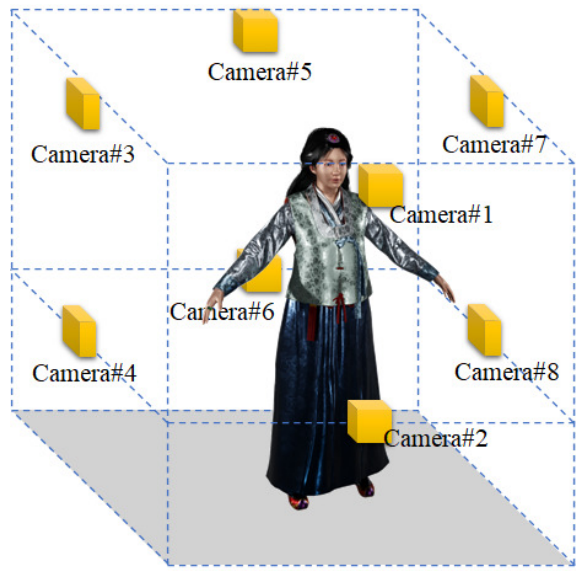
Figure 1. Distributed camera system for scanning photorealistic 3D volumetric model based on point cloud.